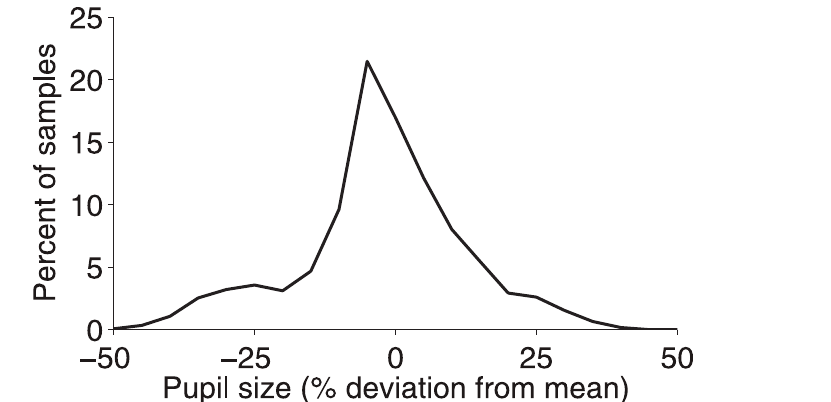
Fig 10. Pupil size fluctuations. Distribution of pupil size deviations from the mean pupil size for all subjects considered in the drift analyses ( n = 3).